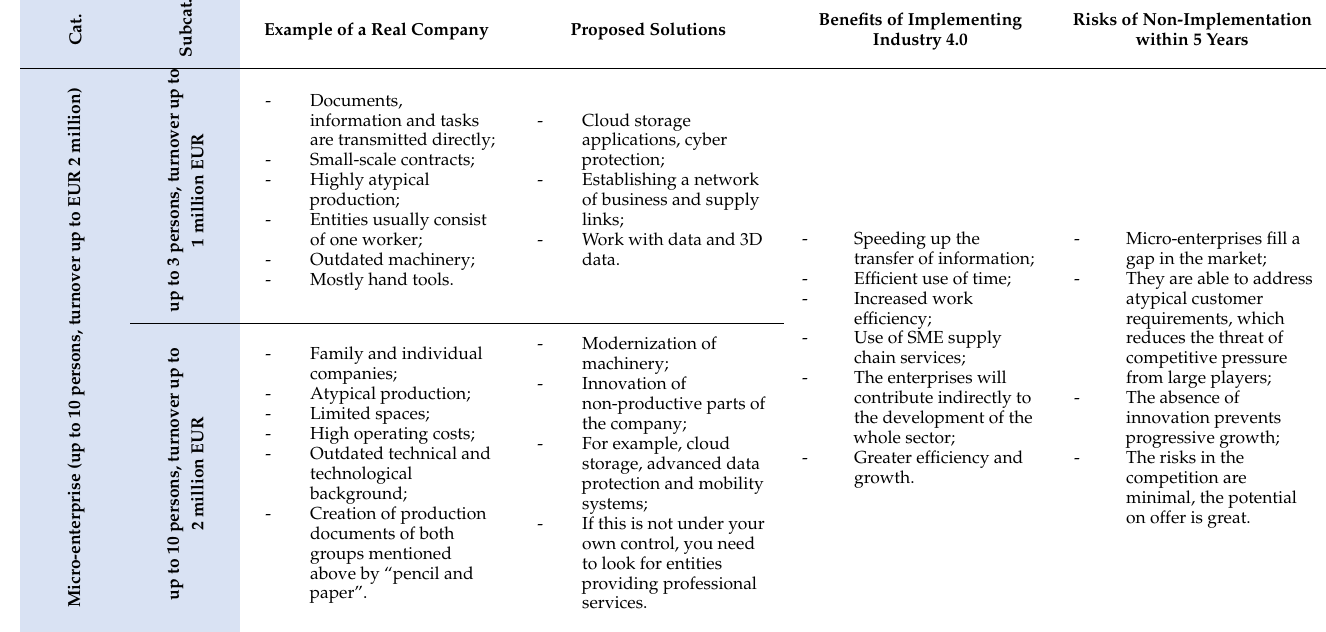
Table 4. Main results and recommendations (scored) for the micro enterprises and the subcategories ( n =